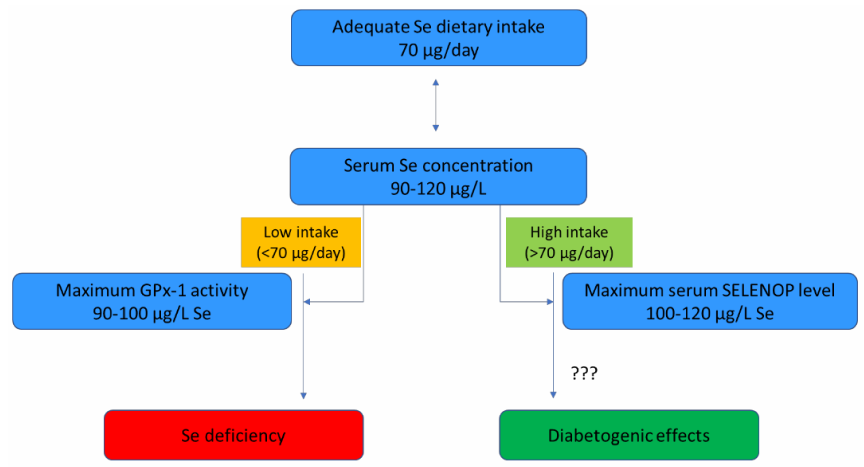
Figure 2. The range of adequate Se dietary intake and its relationship with serum Se levels, the concentration of serum Se biomarkers and potential diabetogenic effects. Abbreviations: GPx-1— glutathione peroxidase 1; Se—selenium; SELENOP—selenoprotein